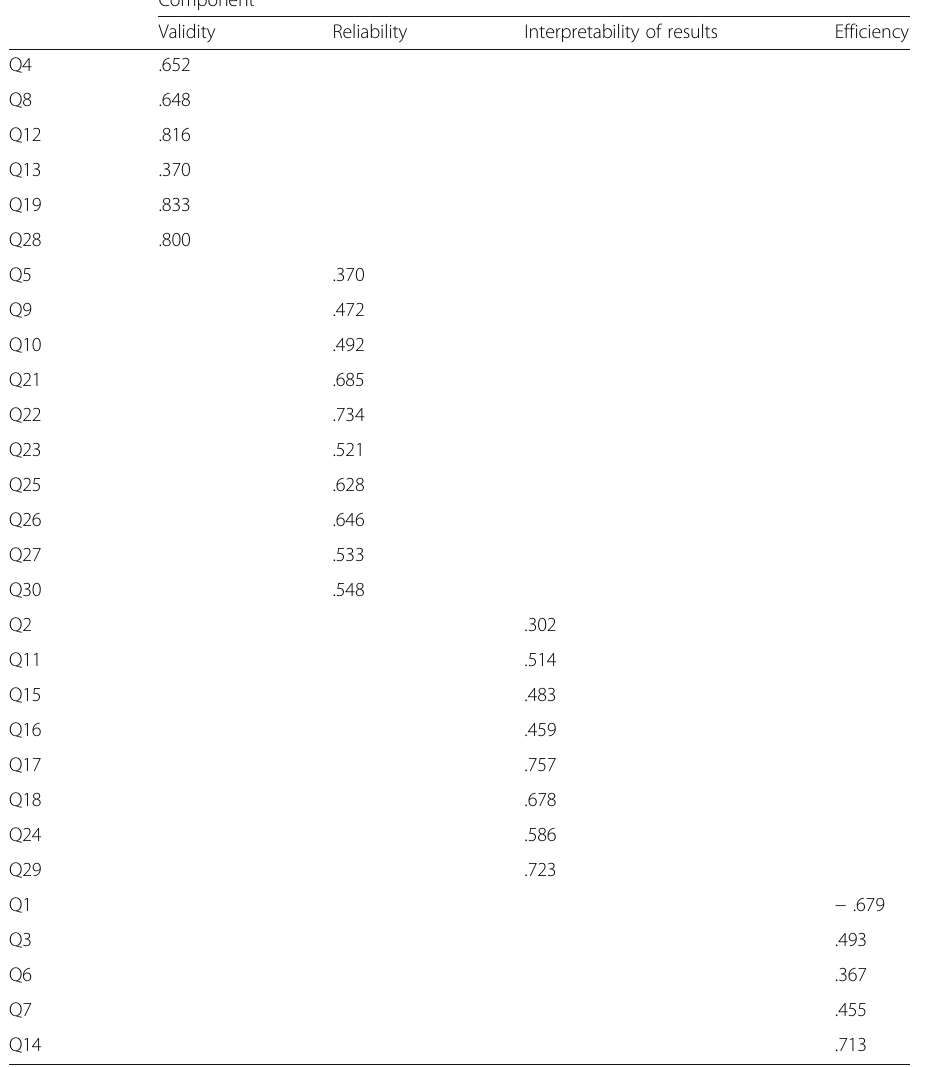
Table 5 Rotated component matrix of the factor analysis of the items in the questionnaire